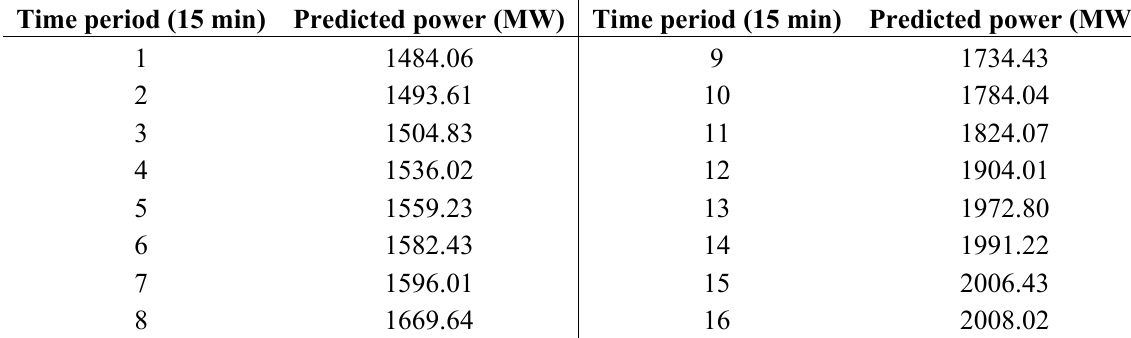
Table 1. Predicted load demand data.